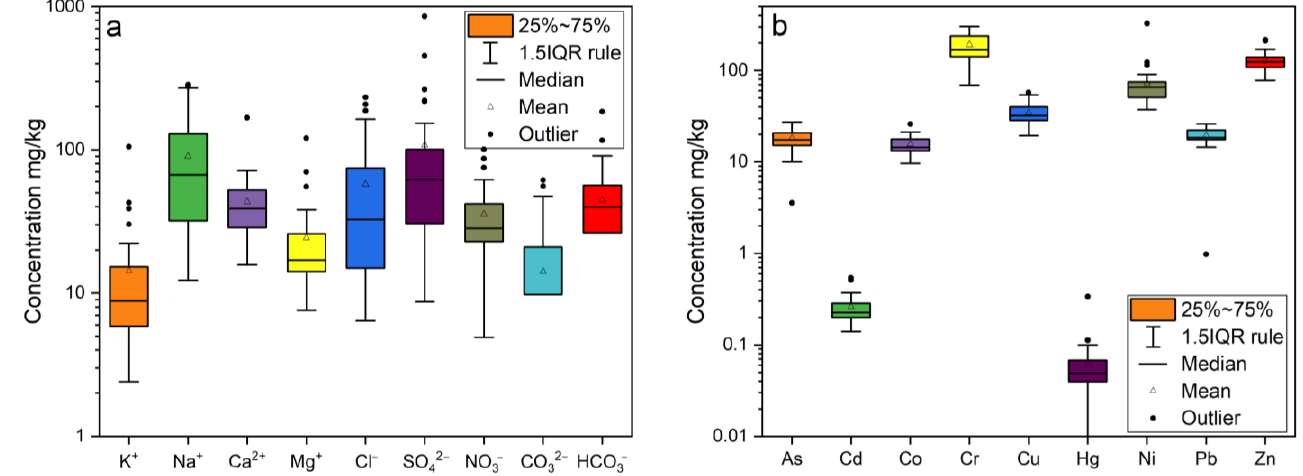
Figure 2. Box plot of anions, cations ( a ) and heavy metal ( b ) concentrations for the 35 surface soils from Hetao Plain in Bayannur.